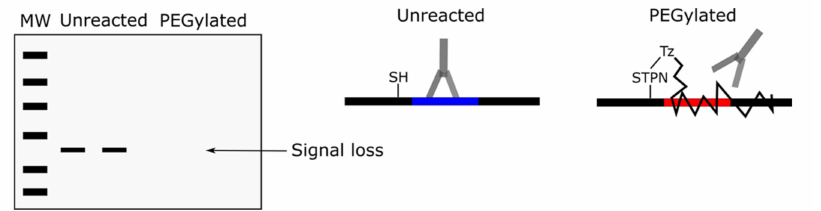
Figure 5. Click PEGylation challenges. Left to right. Signal loss in the PEGylated compared to the unreacted lanes is often observed. In the unreacted samples, the antibody can bind to the epitope. PEGylation, however, may sterically impede epitope binding resulting in partial or complete signal